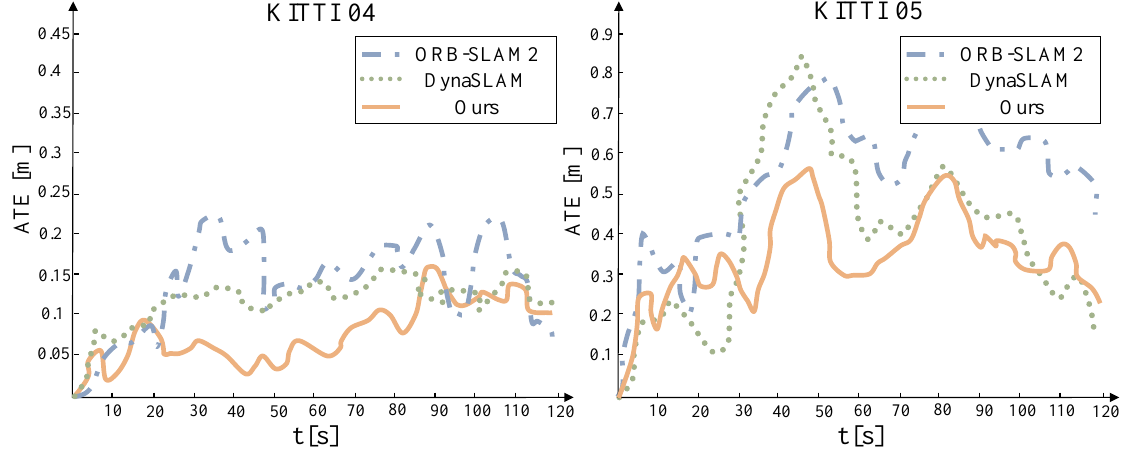
Figure 8. Comparison of camera translation trajectory errors in low-dynamic sequence. As shown in Figure 9, in sequences with high dynamics and large scene changes, the outlier detection method used by ORB-SLAM2 is no longer applicable. It is affected by dynamic objects, and its estimated camera trajectory has a large difference from the ground truth, and even serious errors in some places. At the same time, the performance of this system is far superior to that of DynaSLAM. Although the system’s accuracy is slightly lower than DynaSLAM at certain moments, the error is quickly fixed, and the RMSE decline is significantly smaller than DynaSLAM. This could be due to the difficulty of matching the characteristics of low-texture regions with too comparable scenes. The maximum expected measurement estimation model could predict the system’s excellent pose value in the case of insufficient data